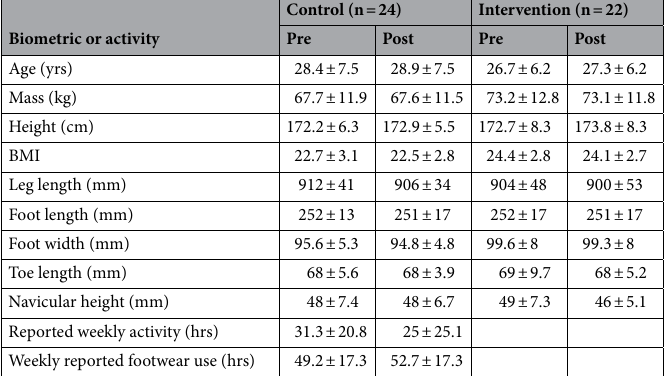
Table 1. Biometrics and activity patterns of the intervention group pre and post intervention period, split into control and intervention sub-groups. “Reported weekly activity” and “Weekly reported footwear use” range over both pre and post intervention columns as these characteristics were taken during the six-month intervention